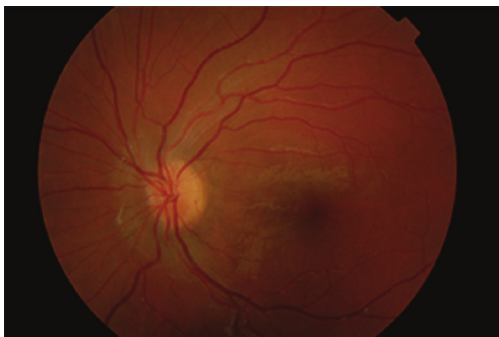
Figure 3: Fundus photography of the patient’s LE ten days after being released in which a remarkable improvement of the optic disc edema is